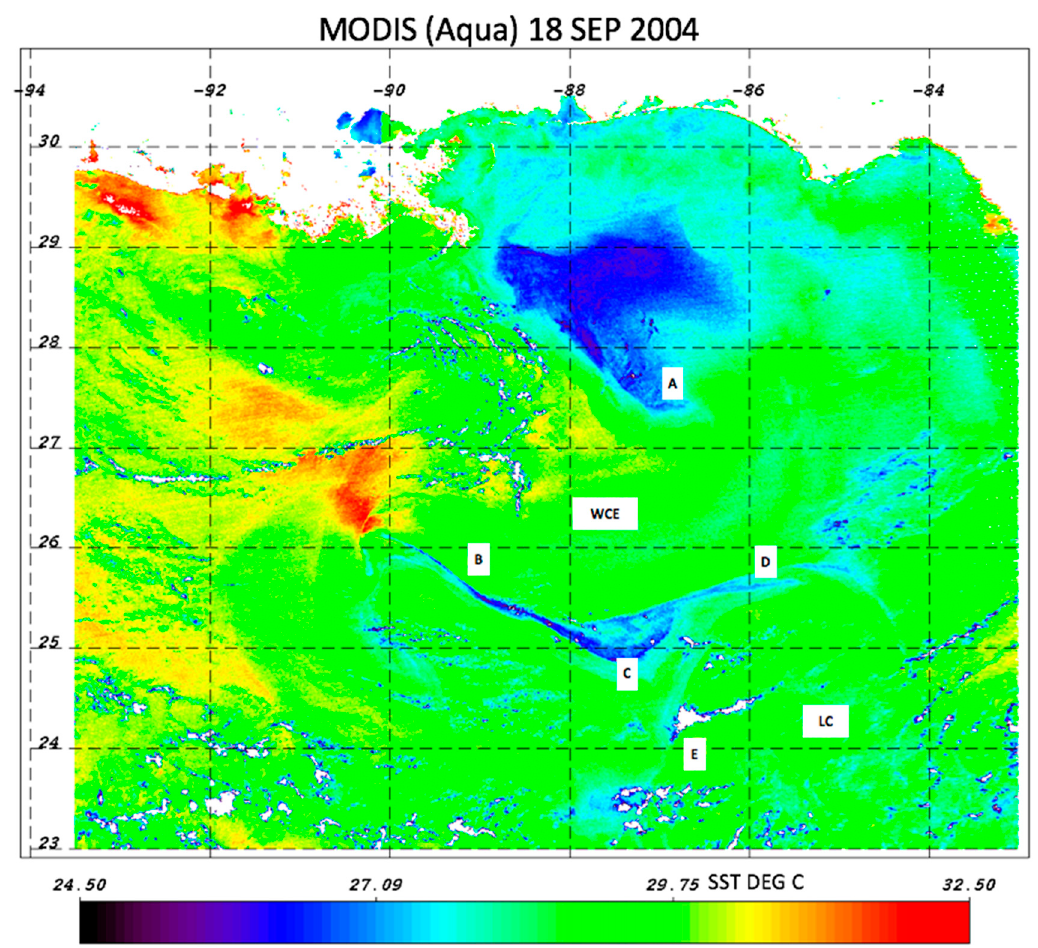
Figure 11. MODIS SST product for 18 September 2004. Labeled areas are as in Figure 10.